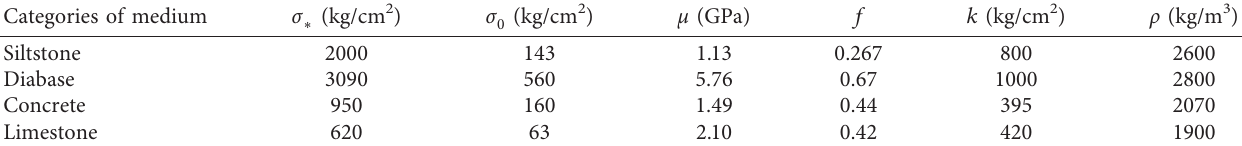
Table 6: Characteristic parameters of different rock and soil types.